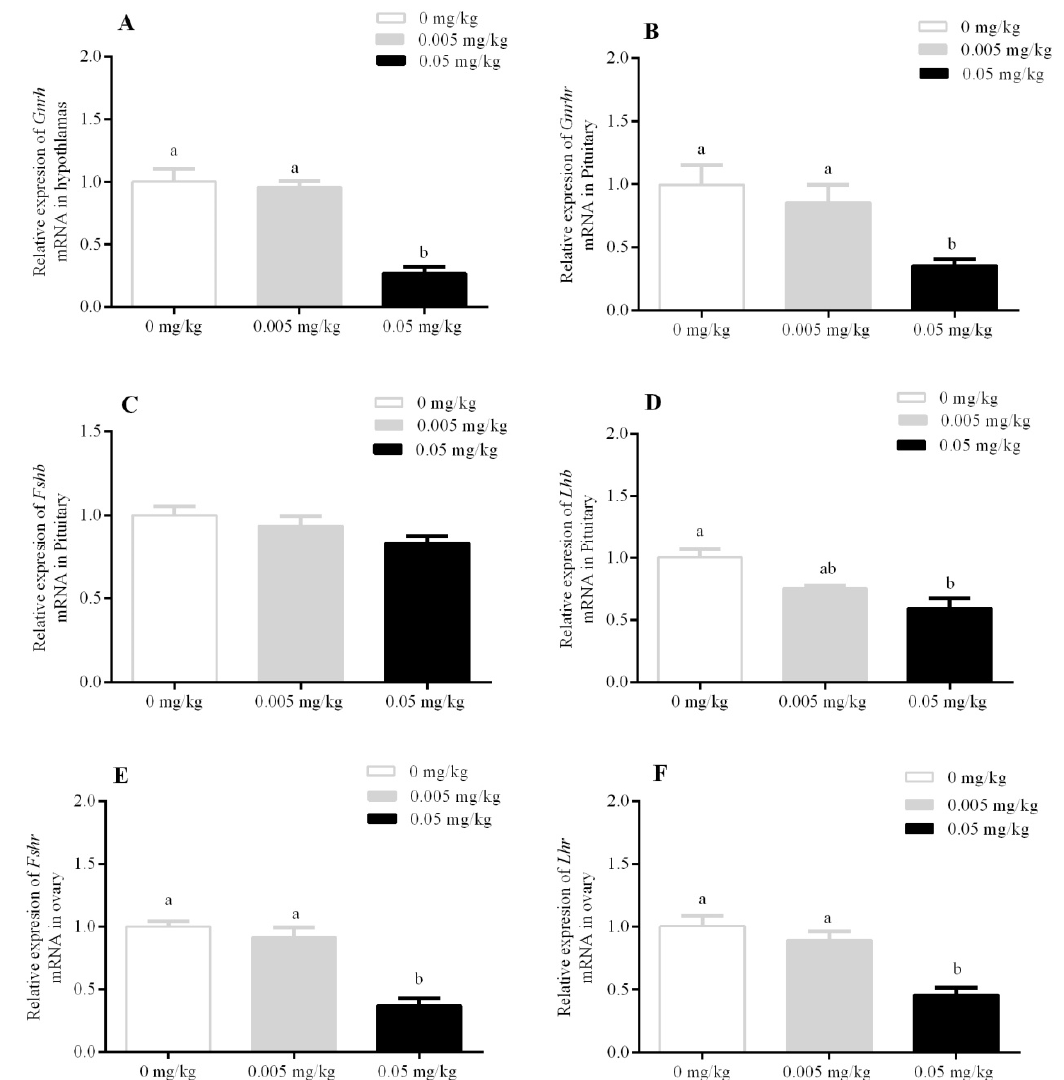
Figure 4. E ff ect of T-2 toxin exposure on relative mRNA expression of ( A ) Gnrh in the hypothalamus, relative mRNA expression of ( B ) Gnrhr, ( C ) Fshb, ( D ) Lhb in the pituitary, relative mRNA expression of ( E ) Fshr and ( F ) Lhr in the ovaries of female mice whose dams were orally administered with T-2 toxin at 0, 0.005, and 0.05 mg / kg from gestational day 14 (GD 14) to lactational day 21 (LD 21). Each value represents the mean ± SEM of the group ( n = 5). Di ff erent letters indicate statistically significant di ff erences, p < 0.05.